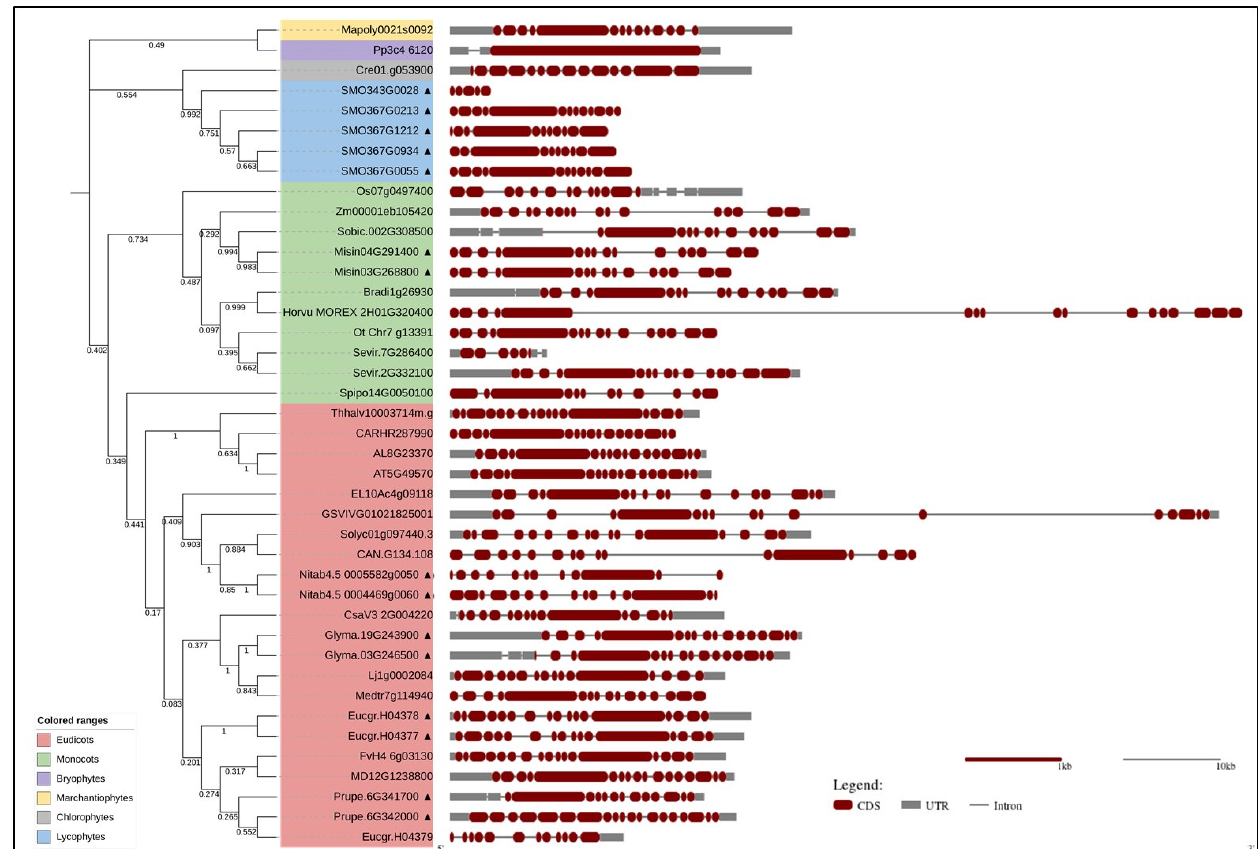
Figure 1. Phylogenetic relationship and gene structure of transglutaminases in various plant species. The phylogenetic analyses were conducted via amino acid sequence alignment using ClustalW and the neighbour-joining method in MEGA-11, and evolutionary distances were computed us- ing the JTT matrix-based method. The proportions of replicate trees in which the associated taxa clustered together in the bootstrap test (1000 replicates) are shown next to the branches. The gene structure, showing the intron/exon pattern, was constructed by The Gene Structure Display Server (GSDS 2.0, (Hu, Jin et al., 2015)) tool (http://gsds.cbi.pku.edu.cn/, accessed on 17 March 2022). Black shaded triangles at the end of gene names represent block/tendem duplication. The trans- glutaminase genes from various plant species used here were as follows: EL10Ac4g09118 ( Beta vulgaris ); Glyma.03G246500 and Glyma.19G243900 ( Glycine max ); AT5G49570 ( Arabidopsis thaliana